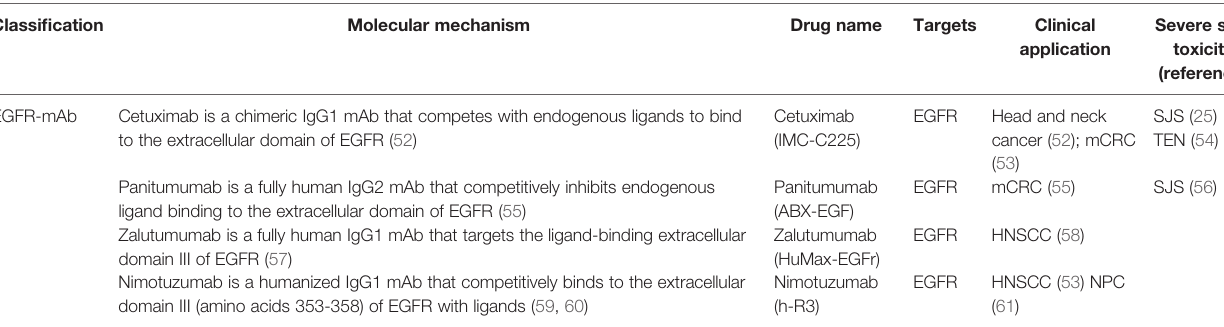
TABLE 2 | Clinically used